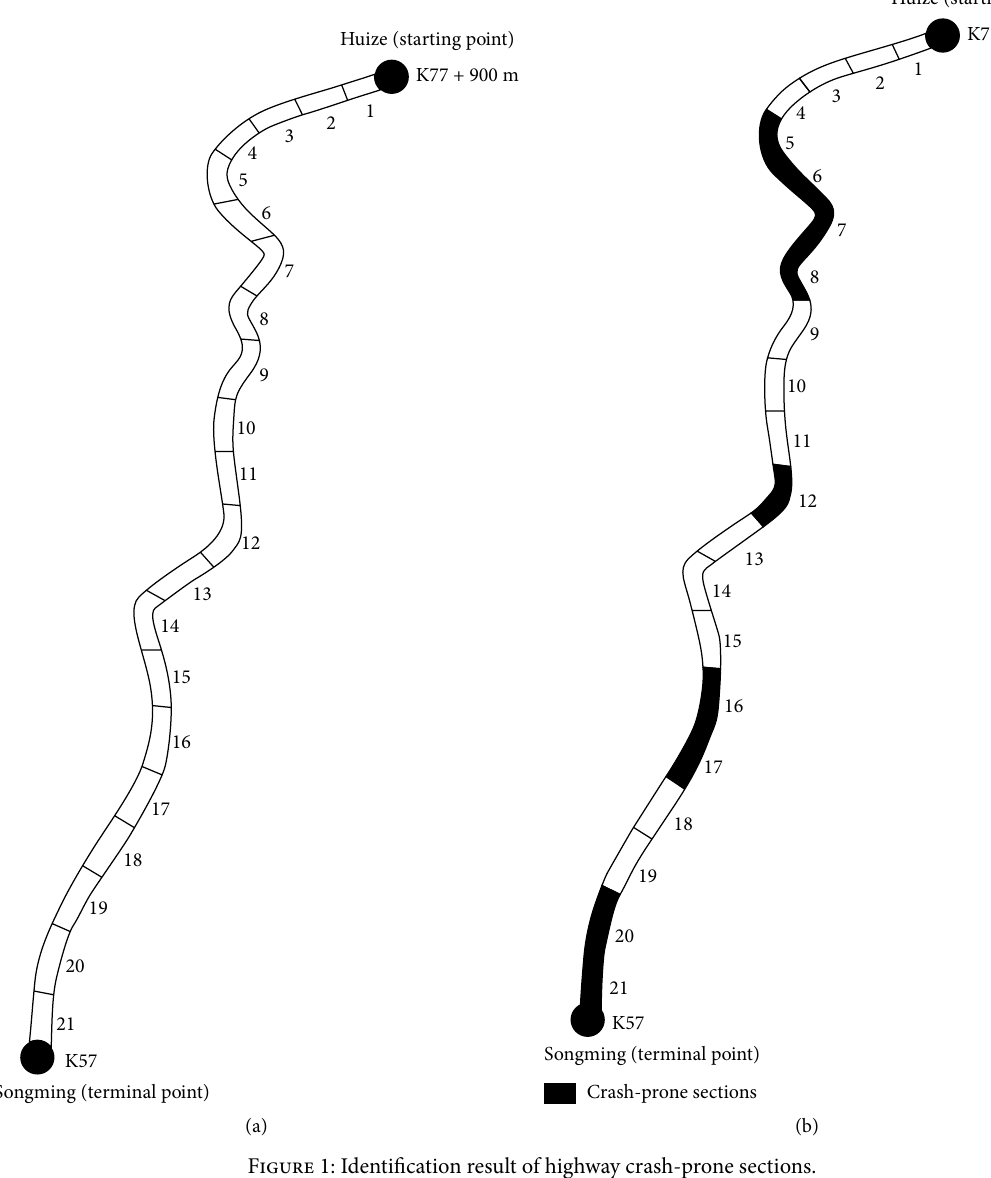
Figure 1: Identification result of highway crash-prone